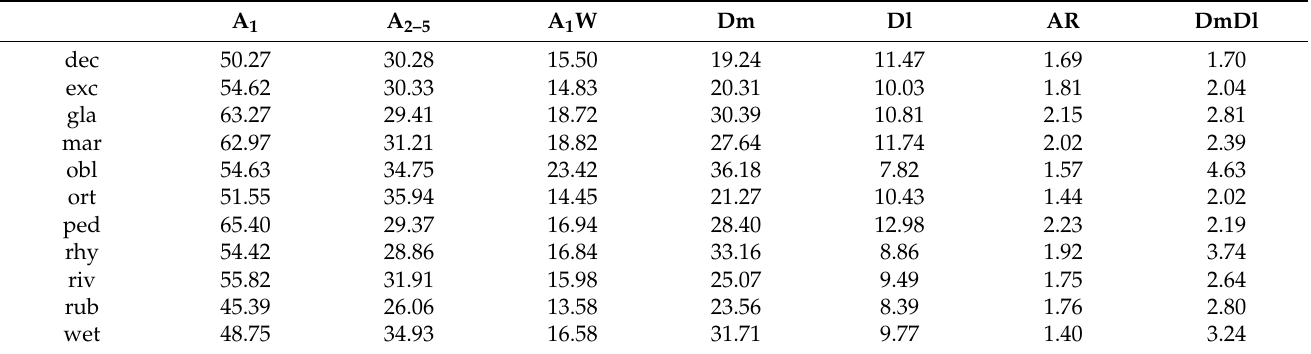
Table 3. Morphometric measures of larval characters: A 1 = length of first antennal flagellomere, A 2–5 = combined length of flagellomeres 2–5, A 1 W = width of the first antennal segment, Dm = width of median tooth of mentum, Dl = wide of first lateral tooth, AR = antennal